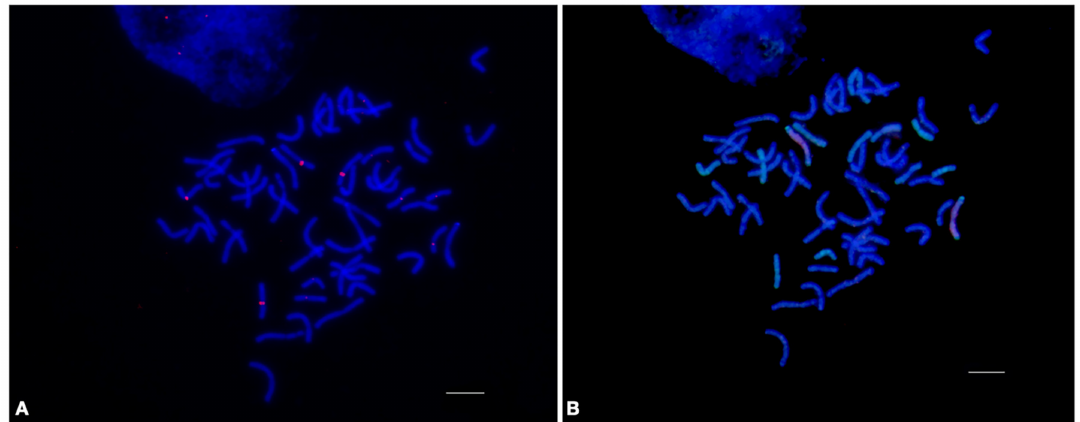
Figure 6. Localization of the 17-202 tandem repeat on the metaphase chromosomes of ( A ) wheat- wheatgrass hybrid 548 using fluorescence in situ hybridization and ( B ) genomic in situ hybridization (GISH) on the same chromosome spread hybridized to total genomic DNA of P. spicata (green) and D. villosum (red) as probes. Green signals indicate the chromosomal localization of the 17-202 tandem repeat. The bar indicates 10 µ